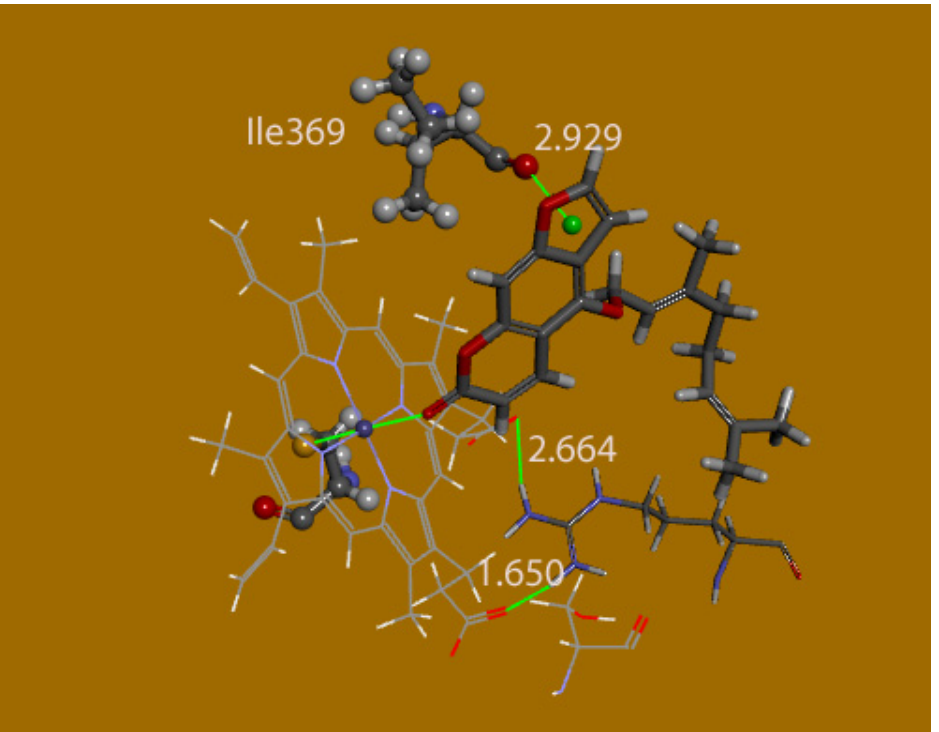
Figure 10. Bergamottin pose 4 showing Heme coordination sphere [d[Fe-O(carbonyl)]] = 2.292 Å, d[Fe-S = 2.258 Å, numbers omitted for clarity] and a lone pair– π interaction, 2.929 Å between Ile − 369 and the furan ring. H-bonds regarding heme carboxylates and Arg105 are 1.650 and 2.664 Å.